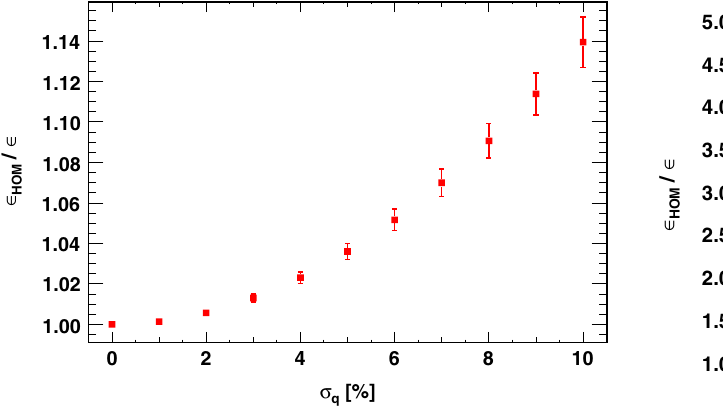
FIG. 9. Average longitudinal phase space increase and devia- tion as a function of the Gaussian bunch to bunch charge scatter. The phase space increases approximately with (cid:5) 2 N ¼ 100 , see Table VI.